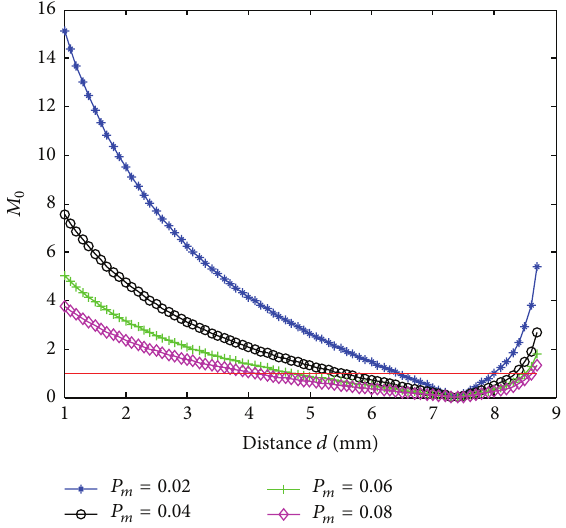
Figure 4: Frequency responses of 𝑀 0 under different excitation amplitudes.